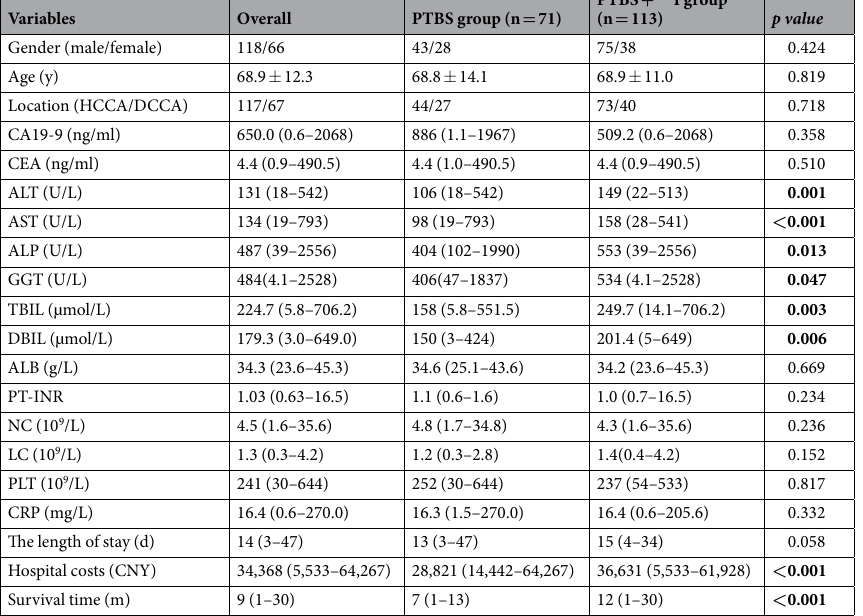
Table 1. Basic characteristics of the included patients. PTBS percutaneous transhepatic biliary stenting, HCCA hilar cholangiocarcinoma, DCCA distal cholangiocarcinoma, CA19-9 carbohydrate antigen 19-9, CEA carcino- embryonic antigen, ALT alanine aminotransferase, AST aspartate aminotransferase, ALP alkaline phosphatase, GGT gamma-glutamyl transpeptidase, TBIL total bilirubin, DBIL direct bilirubin, ALB albumin,